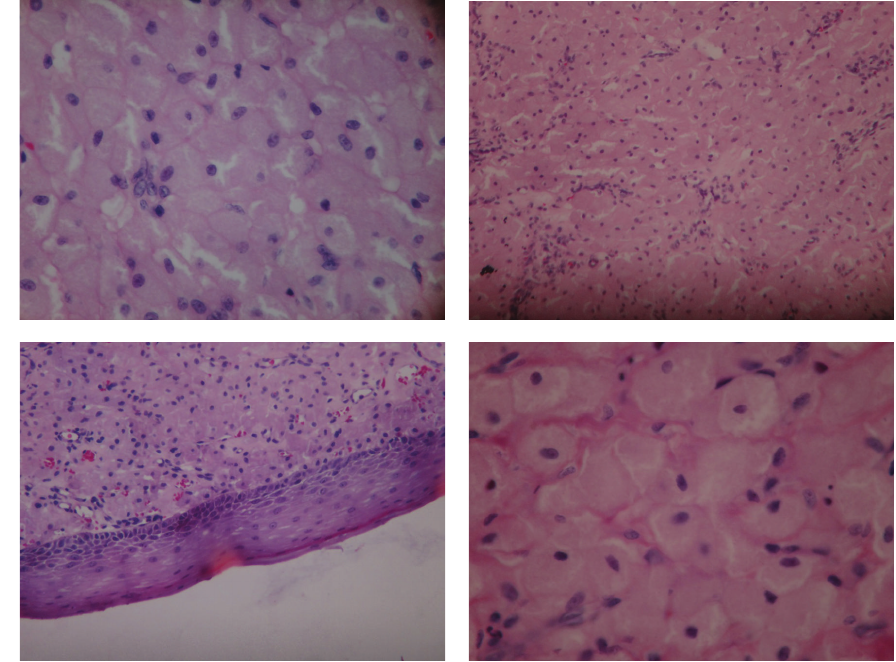
Figure 2: Histopathologic